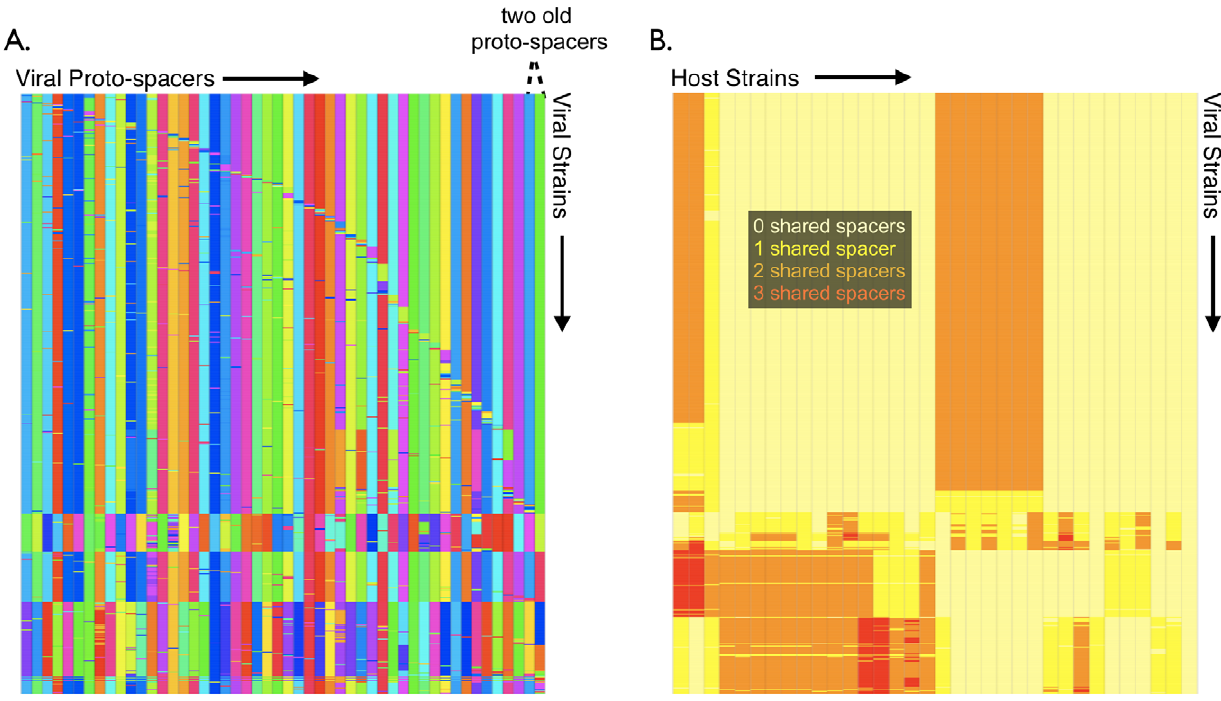
Figure 7. Clustering by immunity reveals diversity during viral bloom. (A) The 651 viruses at the model predicted bloom (iteration 768 in Figure 6B) are shown along the rows, with the virus’ 50 aligned protospacers shown along the columns. Distinct proto-spacers are colored differently. Strains are then clustered based on proto-spacer relatedness. The two proto-spacers providing immunity at the bloom (Figures 6B and S8), are shifted to the two rightmost columns for clarity. Five distinct viral sub-populations are observed in the mosaic, with the largest blooming sub-population characterized by closely related mutants sharing the two critical proto-spacers in their rightmost columns. (B) Viral and host sub-populations at the bloom are superimposed on one another to reveal ‘cloud on cloud’ immunity at the bloom. The rows contain viral strains and the columns show host strains. Each entry of the heat-mapped ‘immunity matrix’ shows the number of shared spacers between the respective host and viral strain. Pale yellow color represents no shared spacers (susceptibility), yellow one shared spacer, orange two shared spacers, and red three shared spacers. The silhouette width (Text S3) was maximized to cluster both hosts (columns) and viruses (rows) into an optimal number of sub-populations based on immunity profiles. Distinct host sub-populations possess immunity to distinct viral